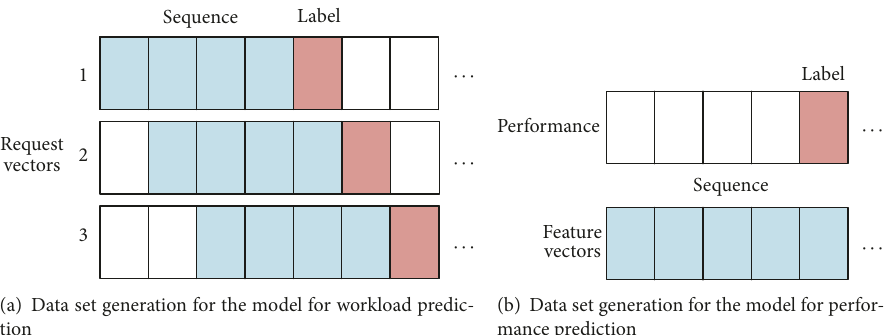
Figure 3: Data set generation for two models: (a) model for workload prediction and (b) model for performance prediction. The blue boxes are the input sequence of the model, and the red box means the label of the sequence. (a) Model for workload prediction: input sequence is a certain number of previous request vectors, and the label is the request vector right after the last request vector of the input sequence. (b) Model for performance prediction: input sequence is a certain number of previous feature vectors, and the label is the performance value of the last feature vector of the input sequence.